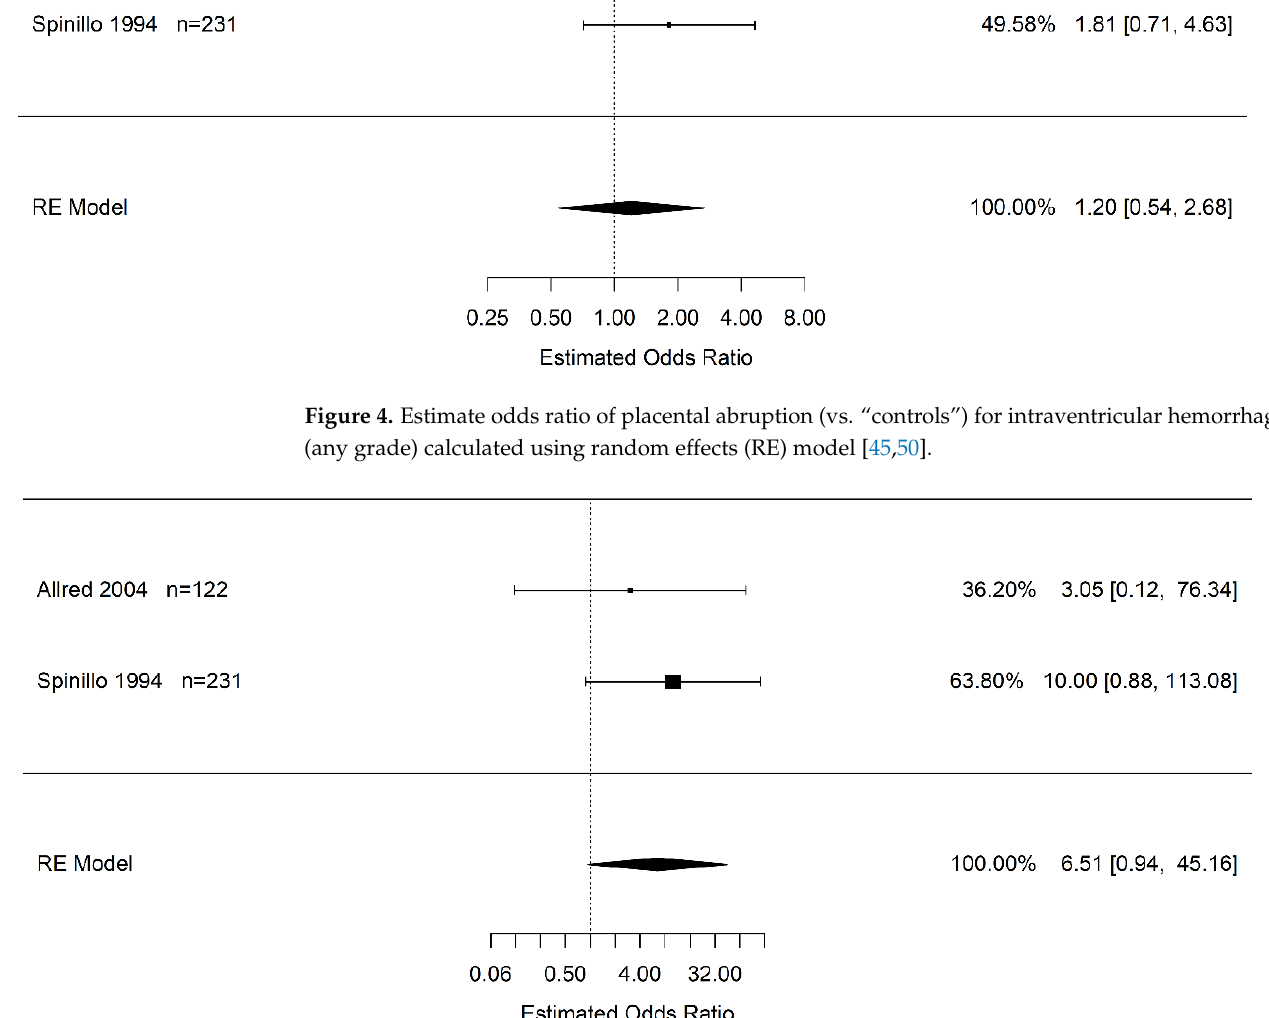
Figure 5. Estimated odds ratio of placental abruption (vs. “controls”) for periventricular leukomalacia calculated using random effects (RE) model. [45,50]